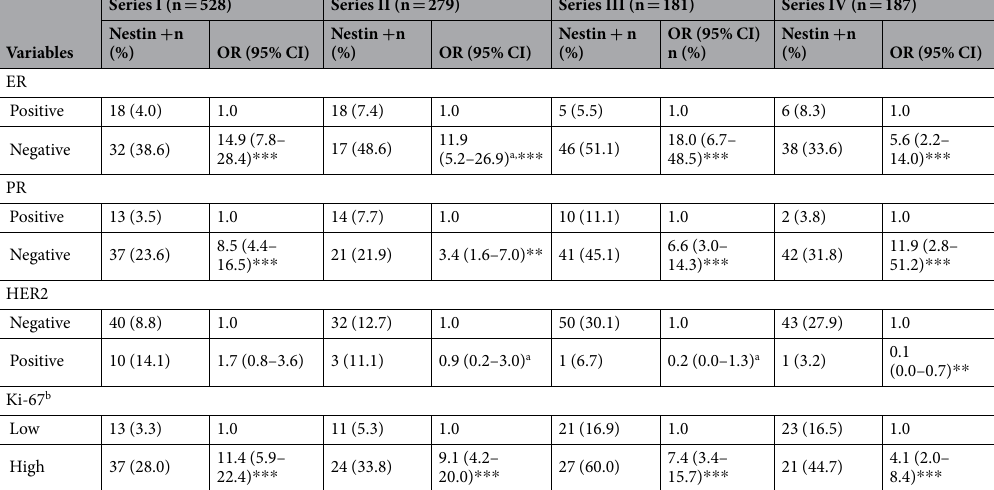
Table 5. Nestin protein expression by receptor status and tumour cell proliferation. a Fisher’s exact test. b Series III, mitosis count by upper quartile, because data on Ki-67 was not available. n: number of patients; OR: odds ratio; CI: confidence interval; p-values by Pearson’s chi-square test, * < 0.05, ** < 0.01, *** < 0.001; ER: oestrogen receptor; PR: progesterone receptor; HER2: human epidermal growth factor receptor 2. Cut-off values: ER and PR positive: ≥ 10%; HER2: see Supplementary Methods; Ki-67: series specific upper quartile, Series I: 31.5, Series II: 23.0, Series IV: 38.7%. Missing data: Series I: HER2: n = 1, Ki-67: n = 1, Series III: Mitosis: n = 12, Series IV: ER: n = 2, PR: n = 2, HER2: n = 2, Ki-67: n =